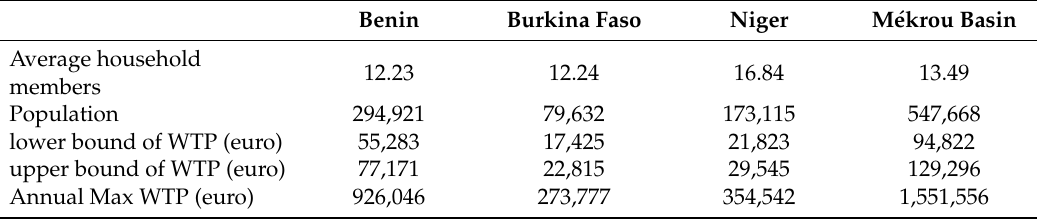
Table 11. Aggregate WTP values for domestic water services in the selected m é krou